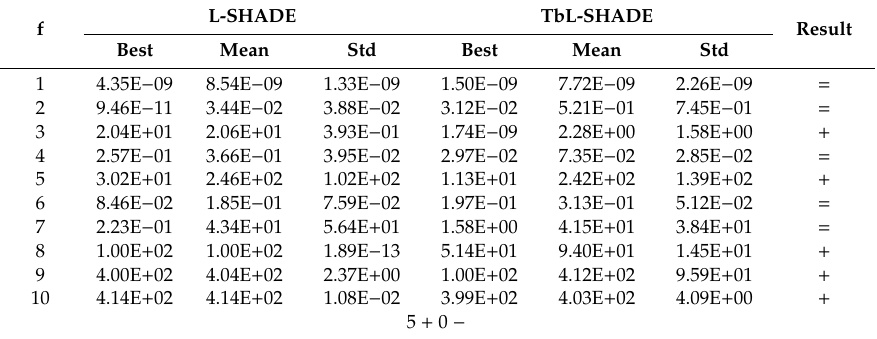
Table 14. L-SHADE vs. TbL-SHADE on CEC2020 in 20 D .